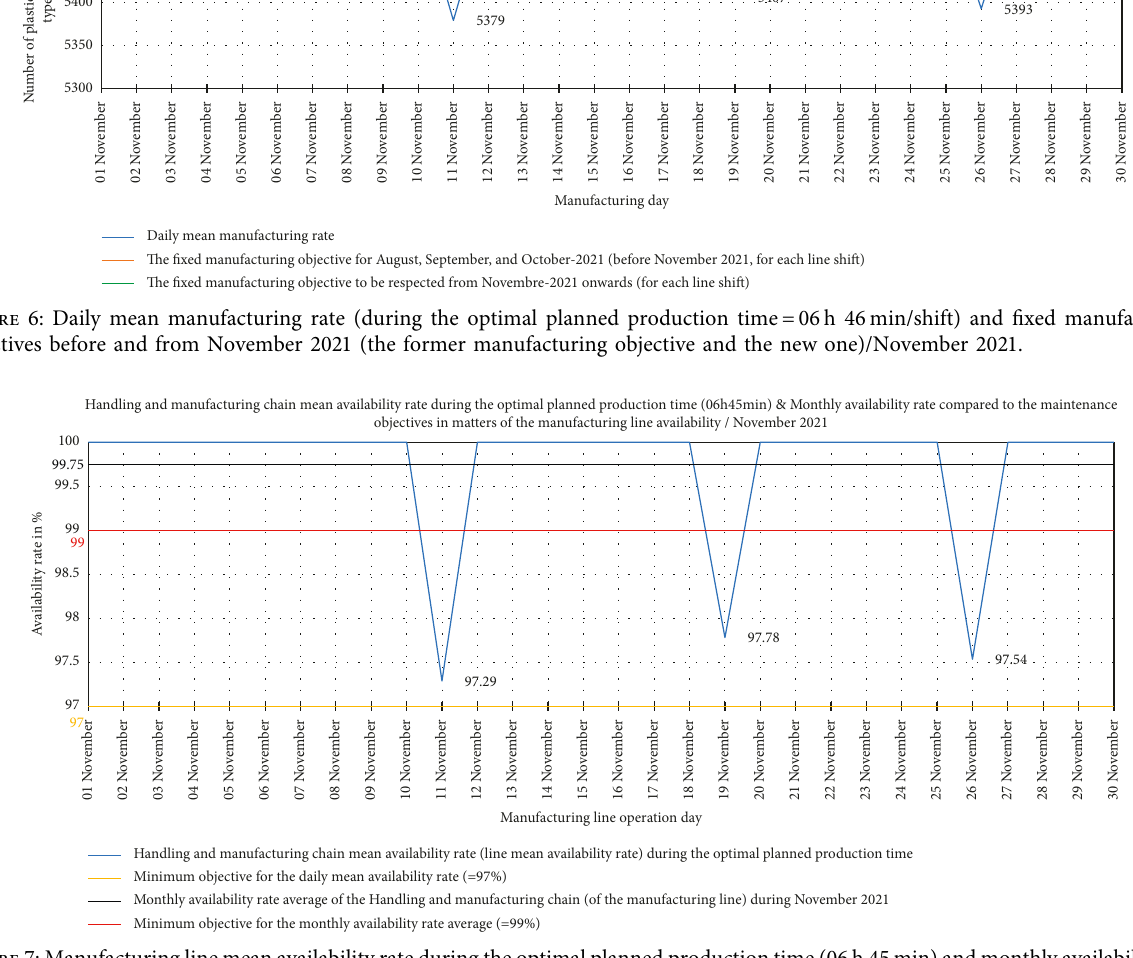
Figure 7: Manufacturing line mean availability rate during the optimal planned production time (06 h 45min) and monthly availability rate compared to the maintenance objectives in matters of the manufacturing line availability/November 2021.